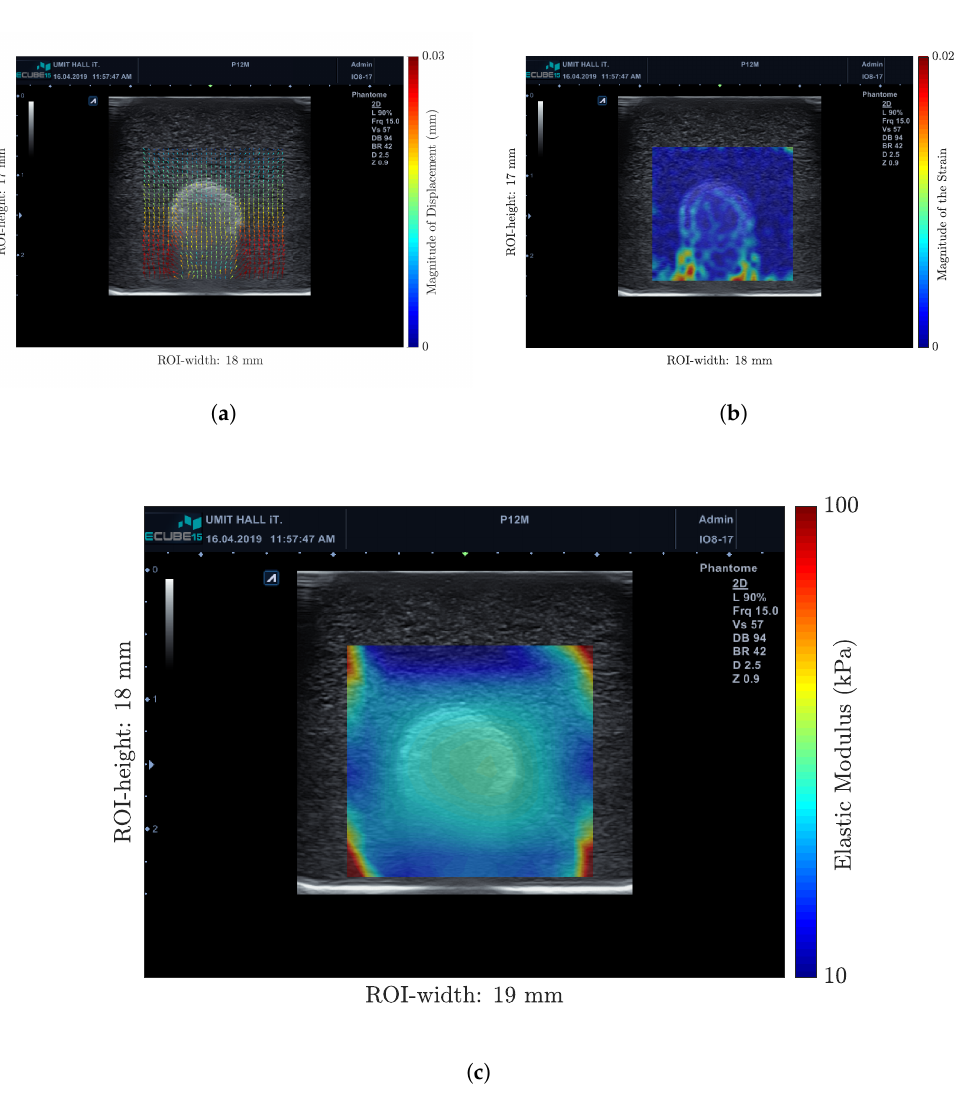
Figure 5. Measurements in the gelatin phantom. The measurement data are superimposed on the US frame; whereas, the displacement between the shown and the previous frame is displayed. ( a ) Displacement field. The color of the vectors indicates the magnitude of the displacement. ( b ) Absolute value of the strain components calculated by Equation (9). ( c ) The elastic modulus estimated by